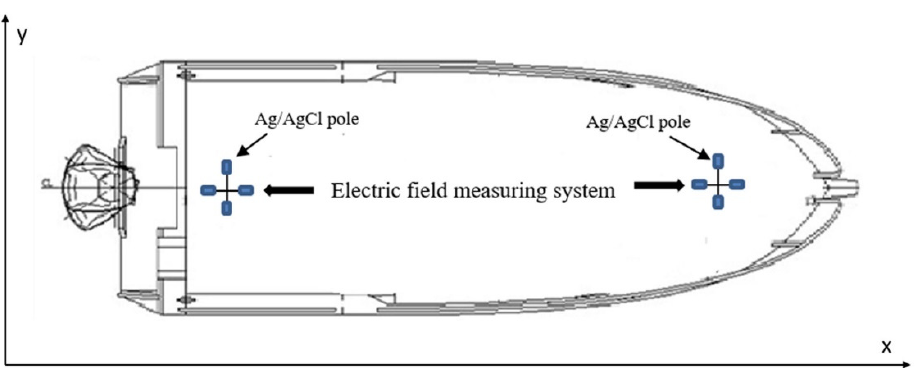
Figure 1. Schematic diagram of electric field measurement system based on fast moving platform.